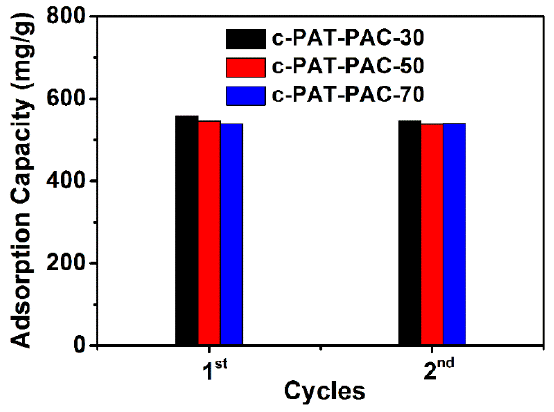
Figure 6. Ni(II) adsorption of PAT–PAC carbon monoliths.